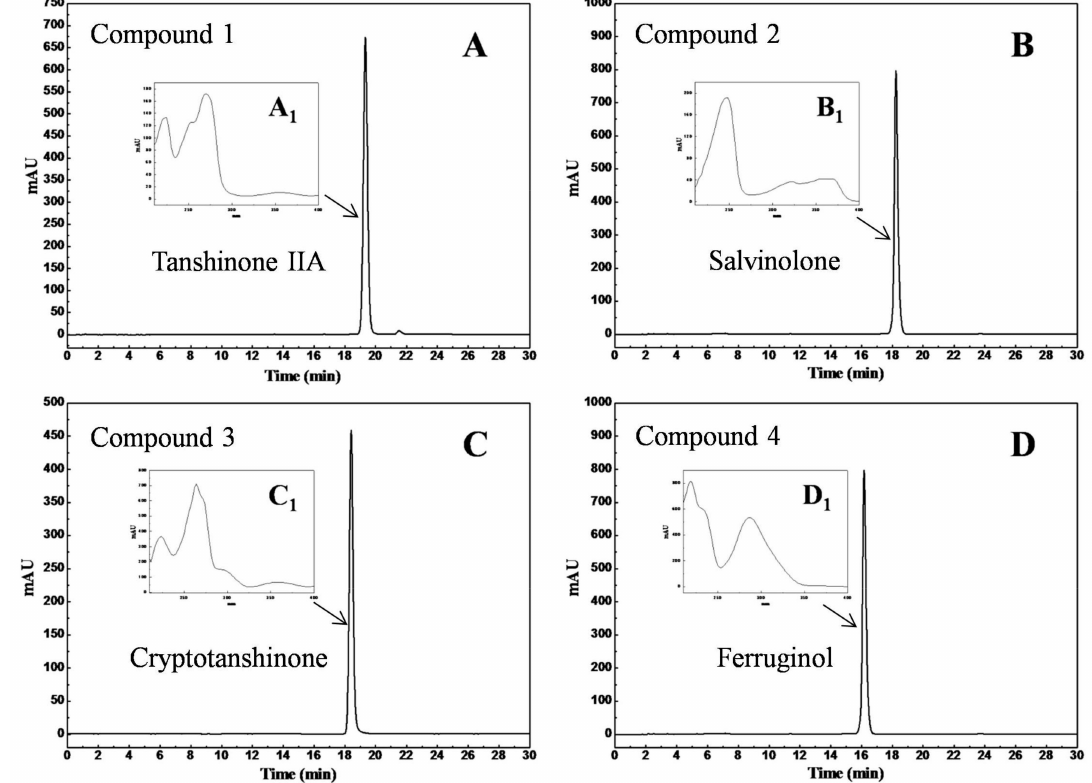
Figure 4. Purity analysis chromatograms ( A – D ) of the isolated compounds on an XAqua C3 analytical column and their UV spectra ( A 1 – D 1 ). Conditions: mobile phase A: water, and mobile phase B: methanol; gradient: 0–30 min, 75%~85% B. Other conditions: monitoring wavelength: 254 nm; flow rate: 1.0 mL/min; injection volume: 10 µ L; column temperature: 25 ◦